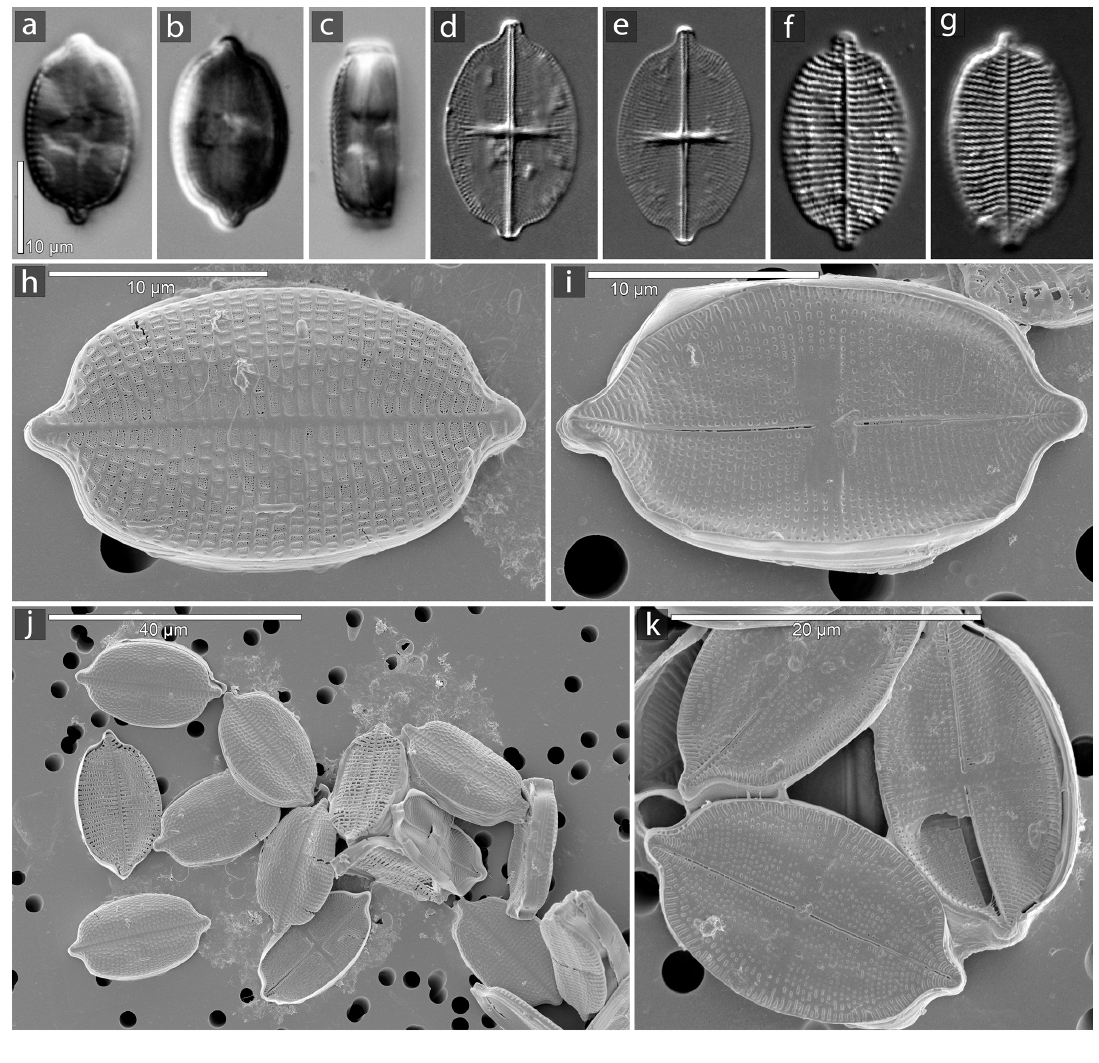
Figure 1. Light (LM) and Scanning electron microscopy (SEM) images of S. trachyderma . ( a – c ): live specimen with plastids. ( a , b ): valve view. ( c ): girdle view. ( d – g ): in LM. ( d , e ): raphe valve. ( f – g ): sternum valve. ( h – k ): in SEM. ( h ): sternum valve. ( i ): raphe valve.